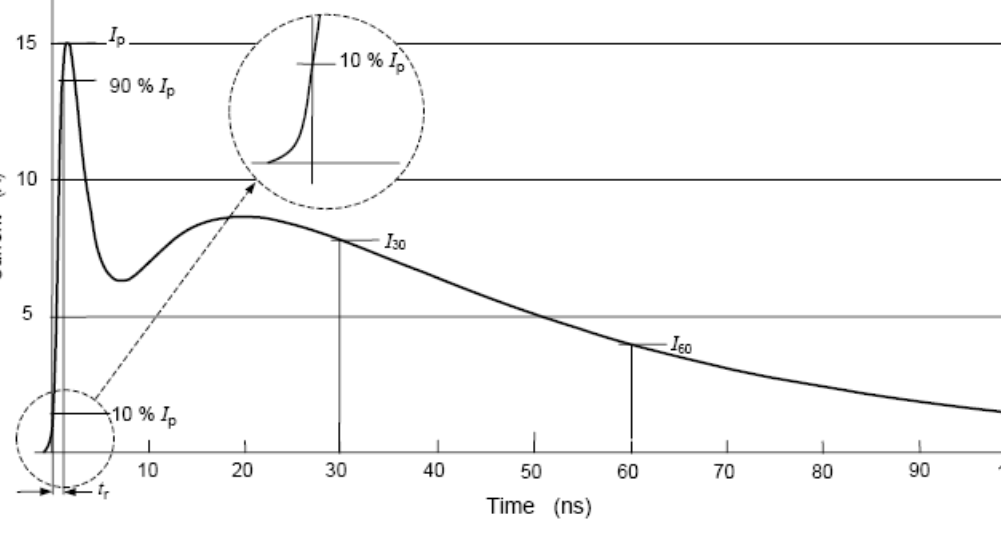
Figure 1. Typical waveform of the output current of an ESD generator